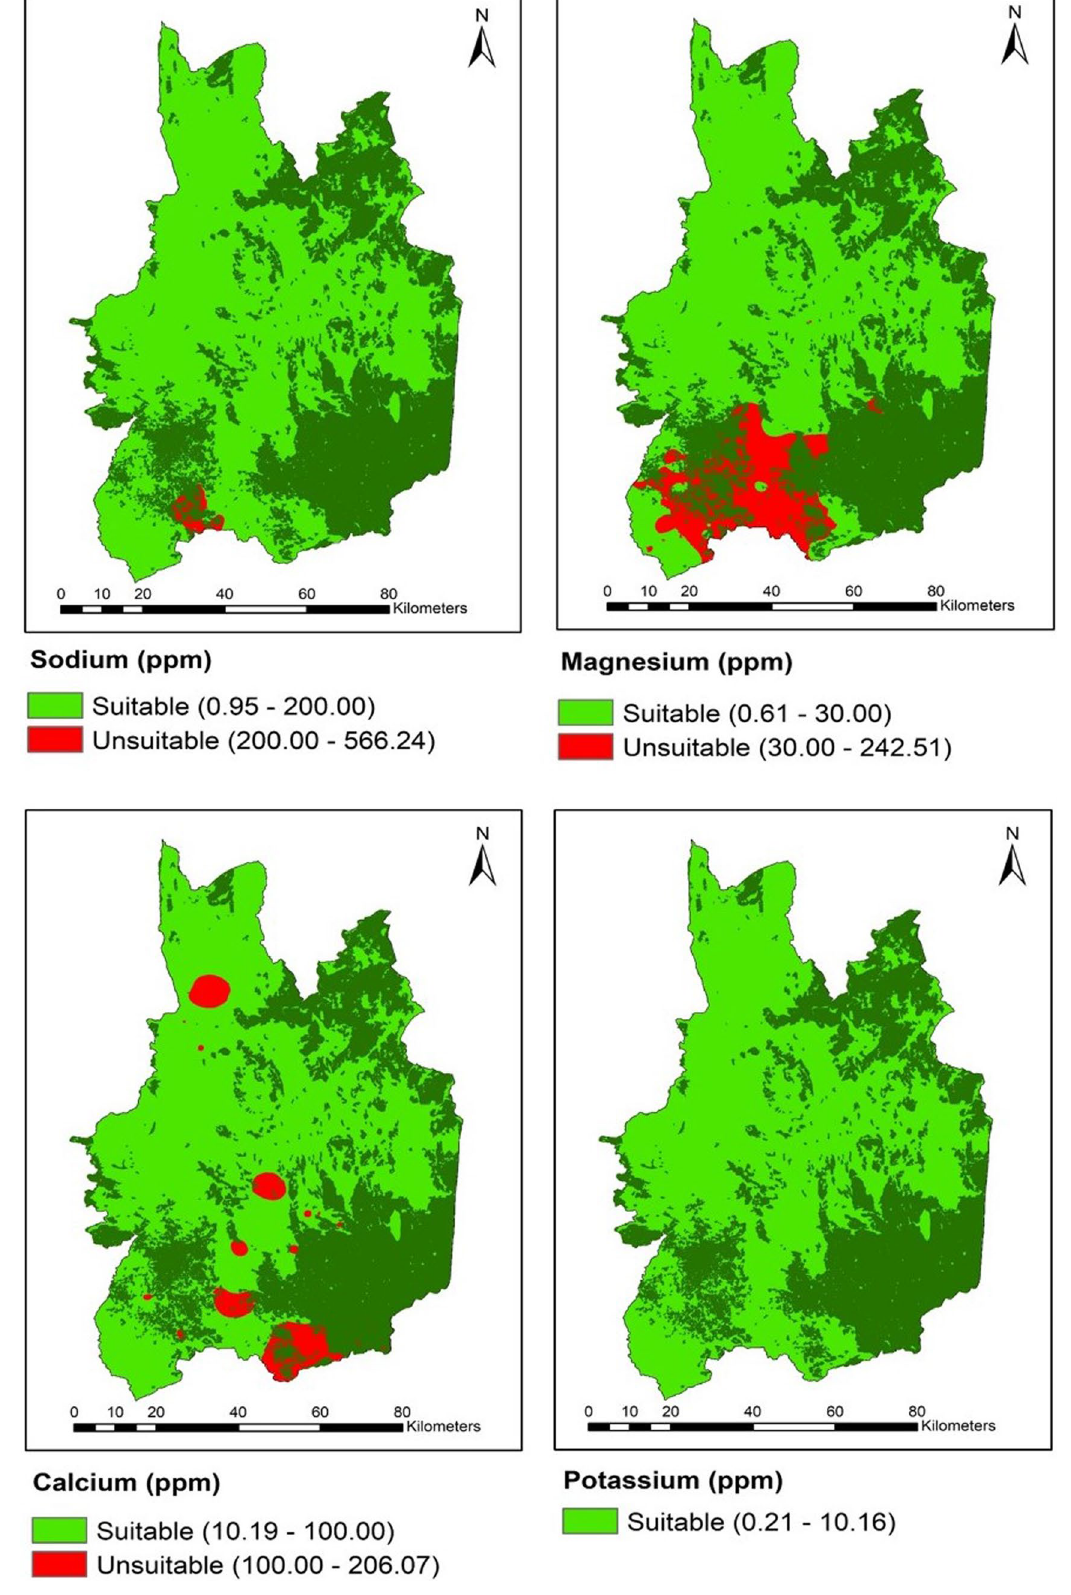
Fig. 5 Maps show spatial distribution of major cations in the